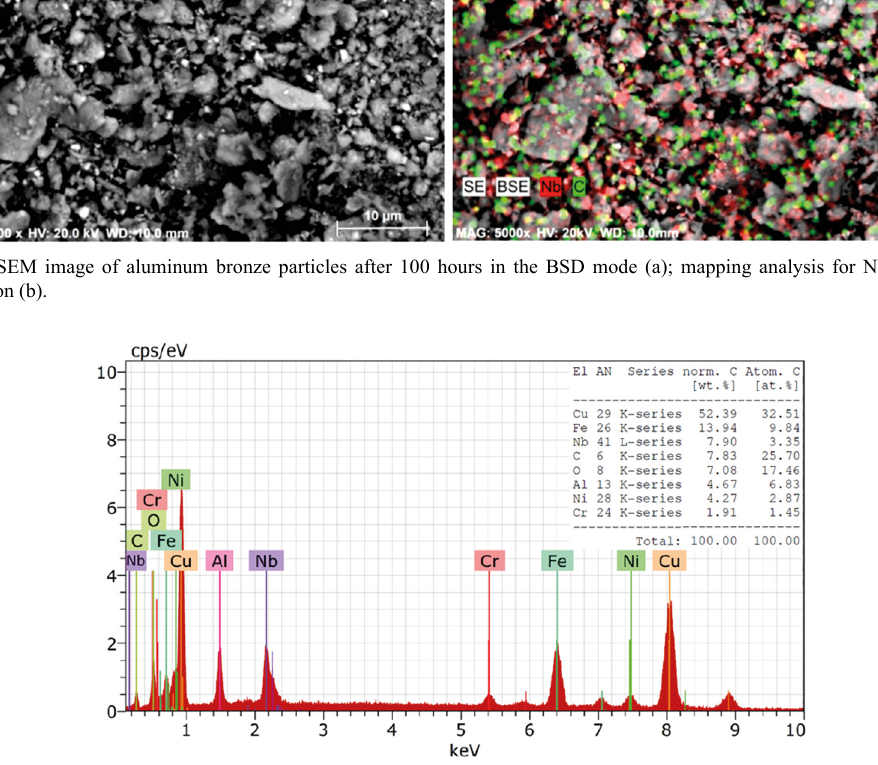
Figure 8. EDS analysis of aluminum bronze for identification of main chemical elements.